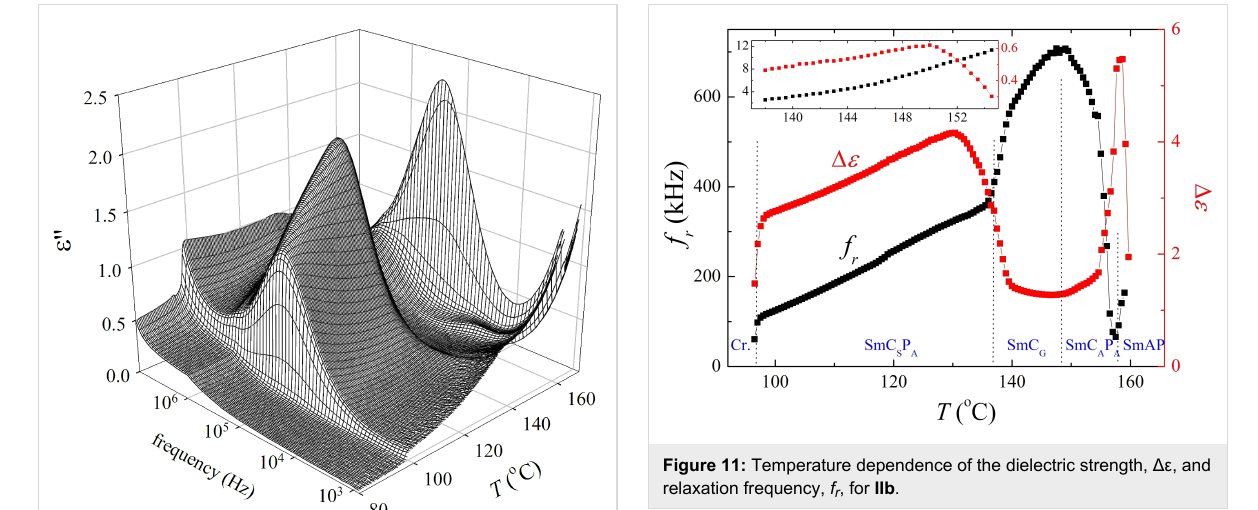
the top and side view of molecules of the SmC G phase (bilayer character is pointed out). From the electro-optical and the dielectric data it follows that chirality changes at the SmC G –SmC S P A phase transition on cooling. Series